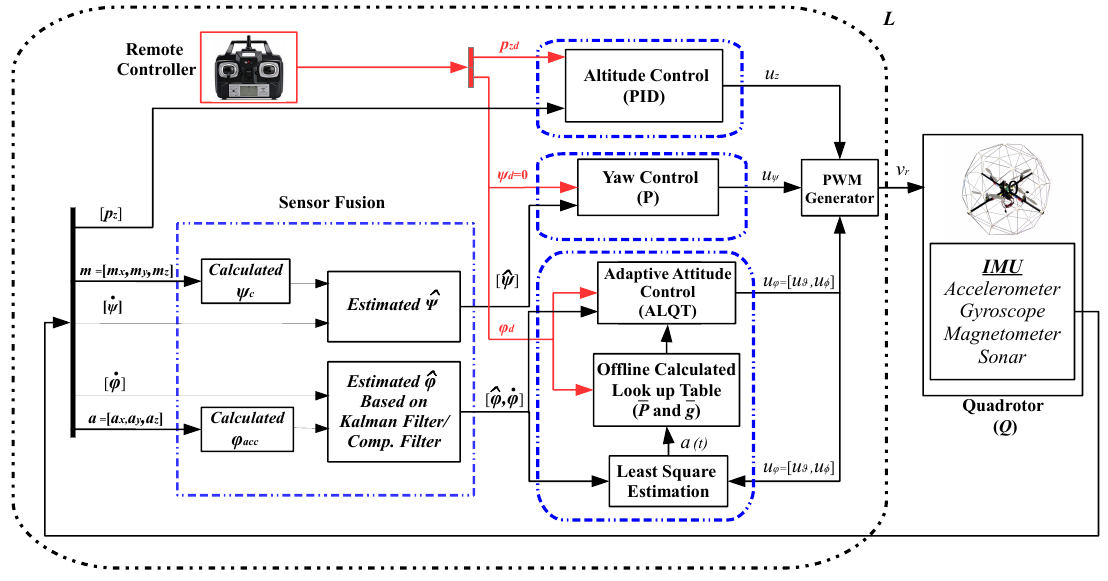
Figure 1. The overall quadrotor UAV control block